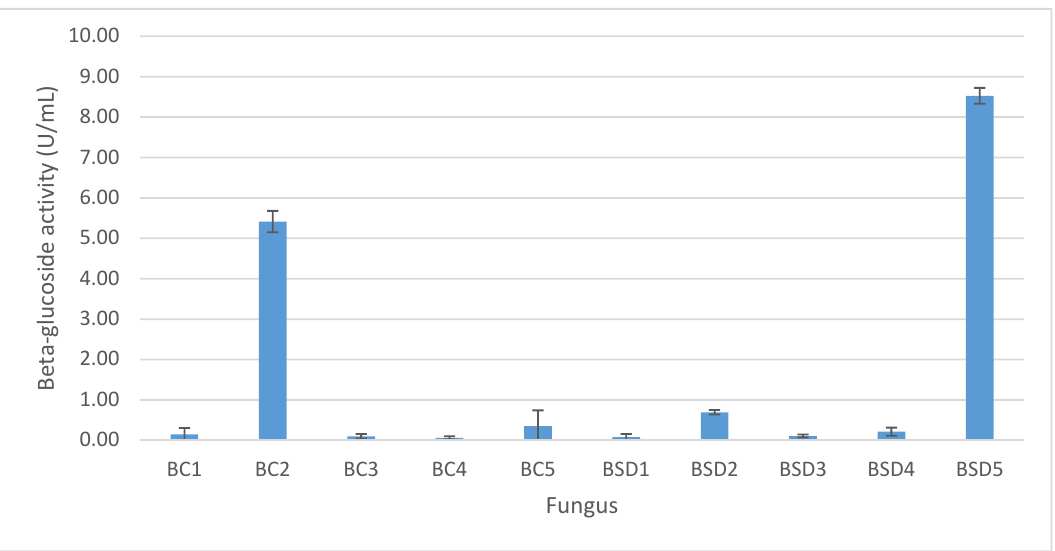
Figure 1. β -glucosidase activity of the isolated fungi.